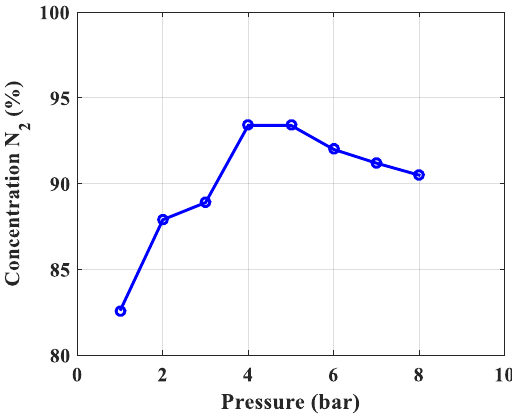
Figure 19. The dependence of N 2 concentration on adsorption pressure.